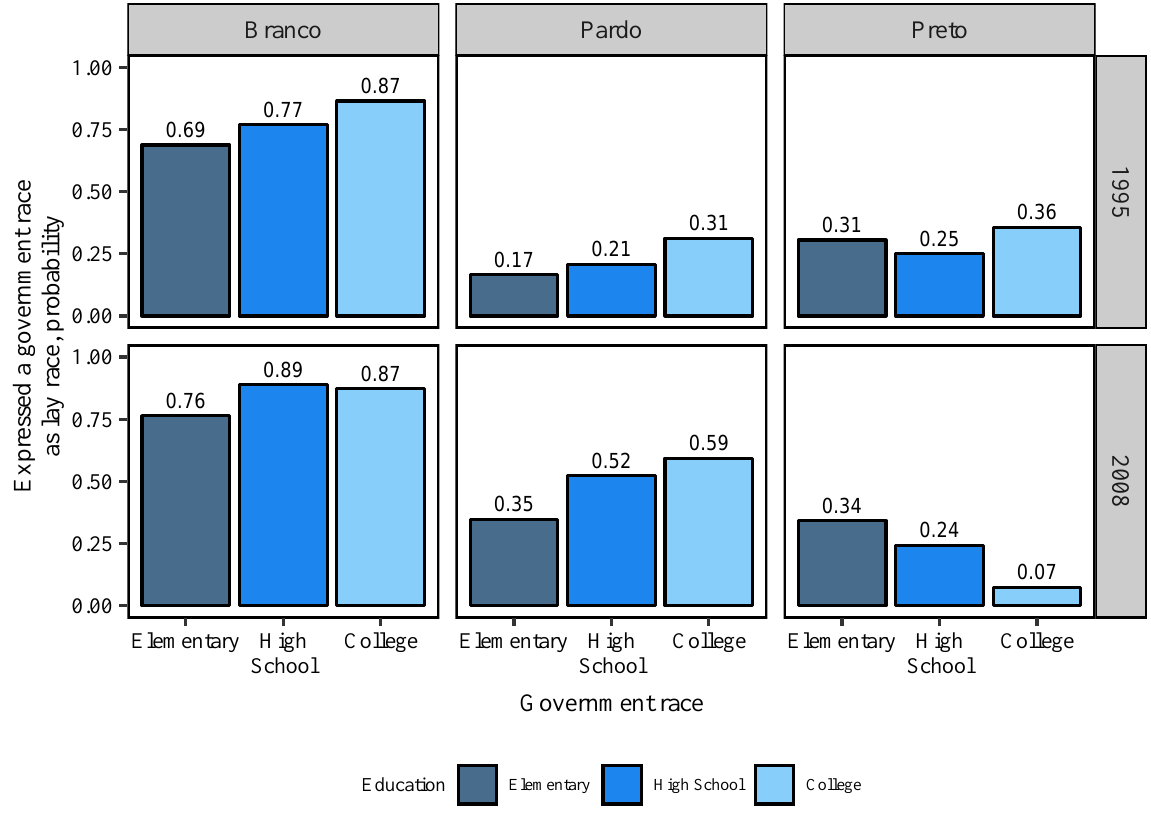
Figure 6: Average predicted probability for dimension alignment by education, 1995 and 2008. Whereas regression coefficients in Figure 4 show that household income was positive and significant in 1995 for dimension alignment, holding constant all other variables, it was neither in 2008. Gender was not significant in either survey year. Figure 4 also provides some evidence of the importance of region in dimension alignment. The strongest effect appears in the Northeast, which is negative and significant in 1995 and 2008, compared to the Southeast reference region. In both years, respondents from the Northeast show a lower probability to express a gov- ernment classification as their lay identification compared to respondents from the Southeast and the South. Respondents from the North and Central-West regions also presented lower probabilities compared to those from the Southeast and South in 1995 but not in 2008. Results overall suggest that dimension alignment has been stronger in the two most economically developed regions in the country (i.e., the Southeast and